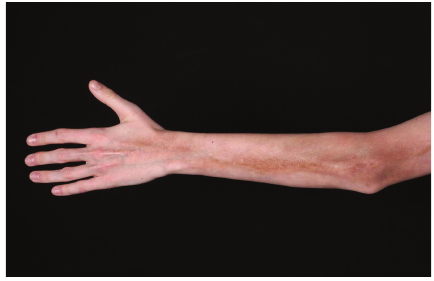
Figure 4: Linear morphea of the upper